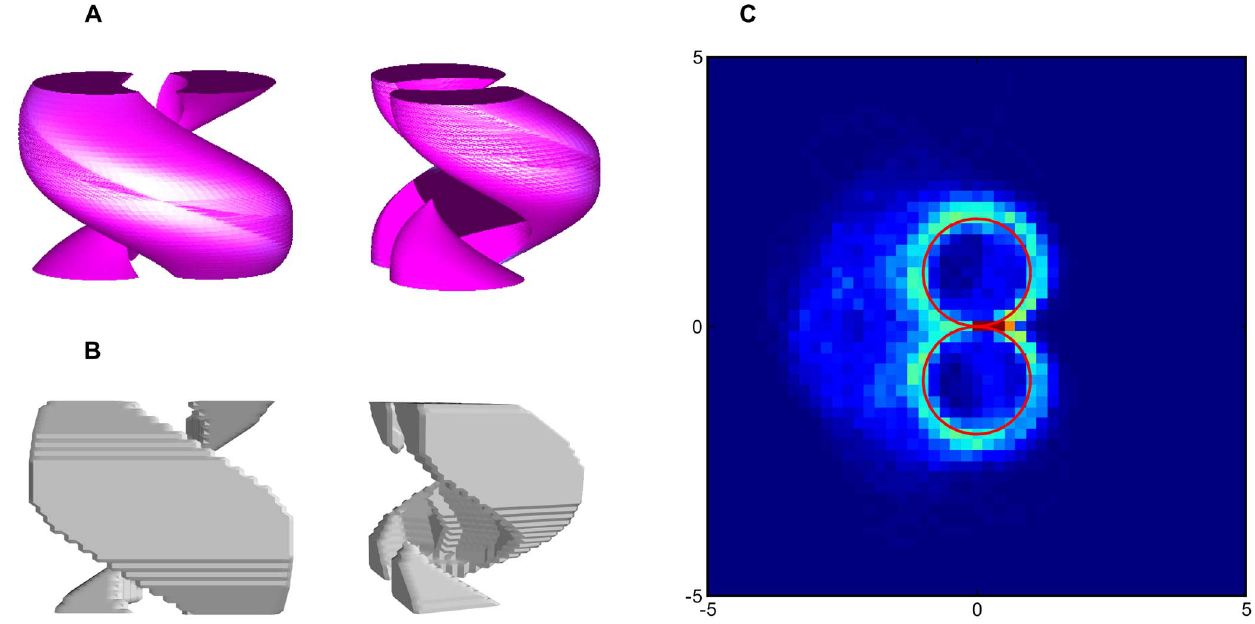
Figure 6. Results obtained for the non-holonomic system. (A) Accessibility volume of the Dubins car obtained with geometrical methods (adapted from [42]). (B) Discrete accessibility volume obtained for the described probabilistic case using the quasimetric method (axes aligned similarly). (C) Average trajectory for 500 simulations of 50 timesteps obtained starting at ( x , y , h ) ~ (0,0,0) with goal at ( x , y , h ) ~ (0,0,0) with a stochastic simulation and a drawn policy. Red curves are the optimal trajectories for a deterministic system.